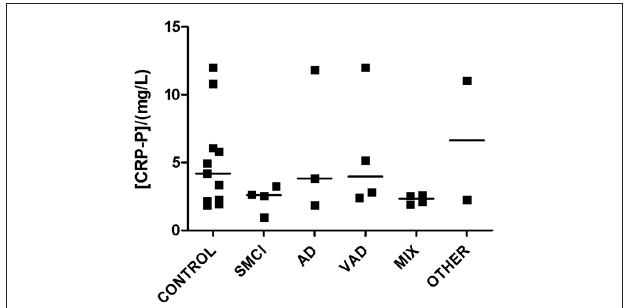
FIguRE 4 | Levels of CRP in plasma. Straight lines indicate median values.